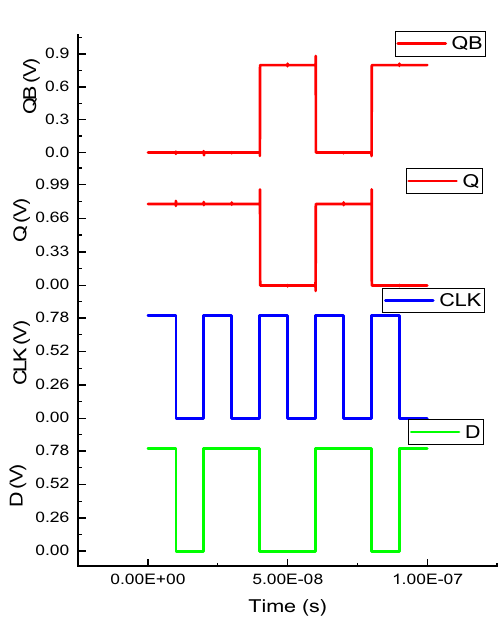
Figure 7. ( a ) D flip-flop realization using NAND leaf cell. ( b ) Timing diagram of D flip-flop using NAND leaf layer/channel width has been increased to 10 nm to increase the ON current. With this, a SS of ~60mV/decade and switching ratio of 1.218×10 12 has been observed. Also, because of low C gd , the trans-conductance g m obtained is high which automatically resulted in high GBP shown in Table 2. Drain induced barrier lowering (DIBL) and GBP are calculated using Equations 5 & 6 respectively. The DIBL of the device is approximately close to zero (2.75 mV/V) due to high doping concentrations and also due to the absence of junctions. Equation 6 is used to calculate DIBL at drain voltages of 1 V and 0.2 V. It is to be noted that even with thin oxide, the leakage current is very low, and that the switching ratio is very high.